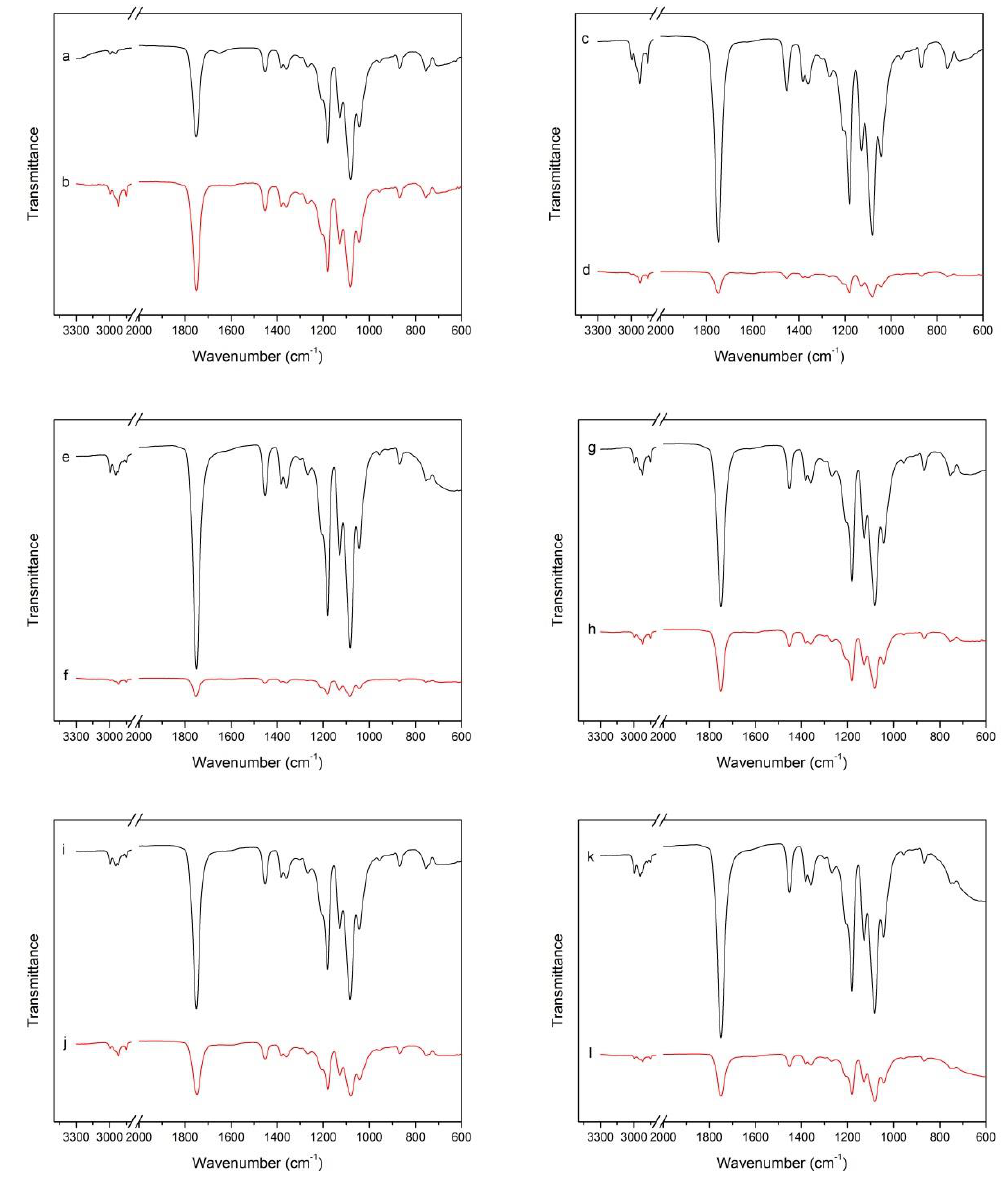
Figure 1. ( a , c , e , g , i , k ) represents the FTIR patterns of composite film PLA-0, PLA-1%, PLA-5%, PLA-10%, PLA-15% and PLA-20% before high pressure treatment, respectively; ( b , d , f , h , j , l ) represents the FTIR patterns of composite film PLA-0, PLA-1%, PLA-5%, PLA-10%, PLA-15% and PLA-20% after high pressure treatment, respectively.